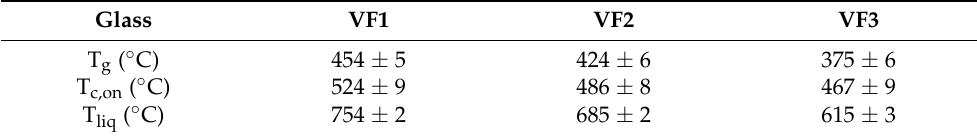
Table 2. Glass transition (T g ) crystallization (T c, on ) melting (T m ) temperatures for concentrations of [K 2 O/(CaO+MgO)] ratio (%mol). VF1: 0.67 %mol, VF2: 1.33 %mol and VF3: 2